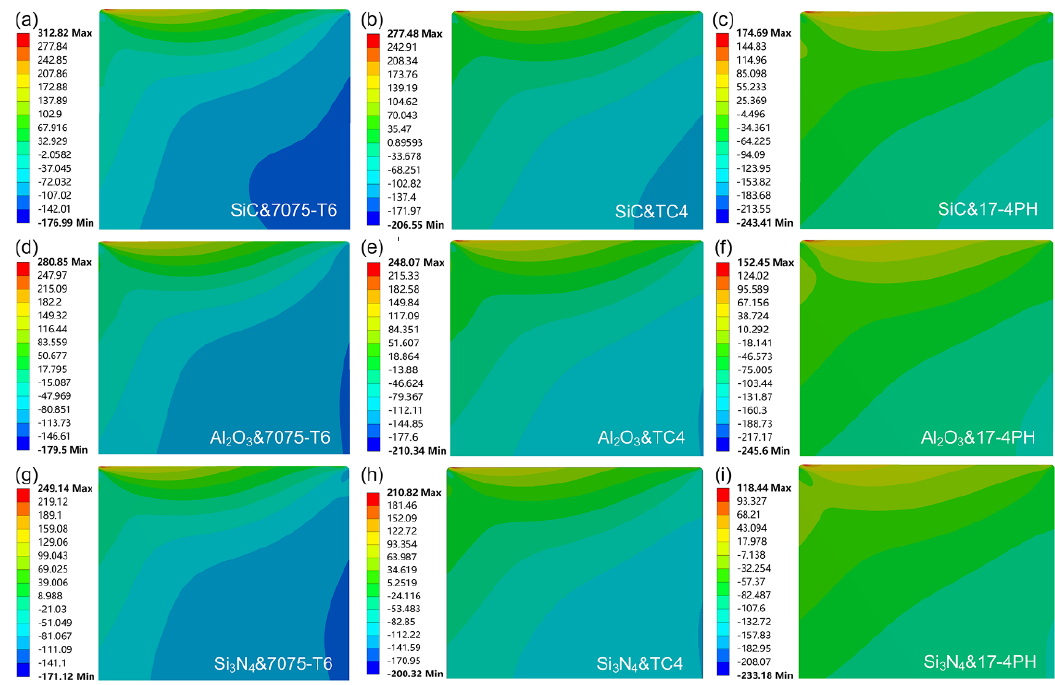
Figure 6. The tensile stress on the nine groups of ceramic contact faces at the preliminary designed dimensions and hydrostatic pressure of 115 MPa. ( a – c ) SiC&7075-T6, SiC&TC4, and SiC&17-4PH; ( d – f ) Al 2 O 3 &7075-T6, Al 2 O 3 &TC4, and Al 2 O 3 &17-4PH; ( g – i ) Si 3 N 4 &7075-T6, Si 3 N 4 &TC4, and Si 3 N 4